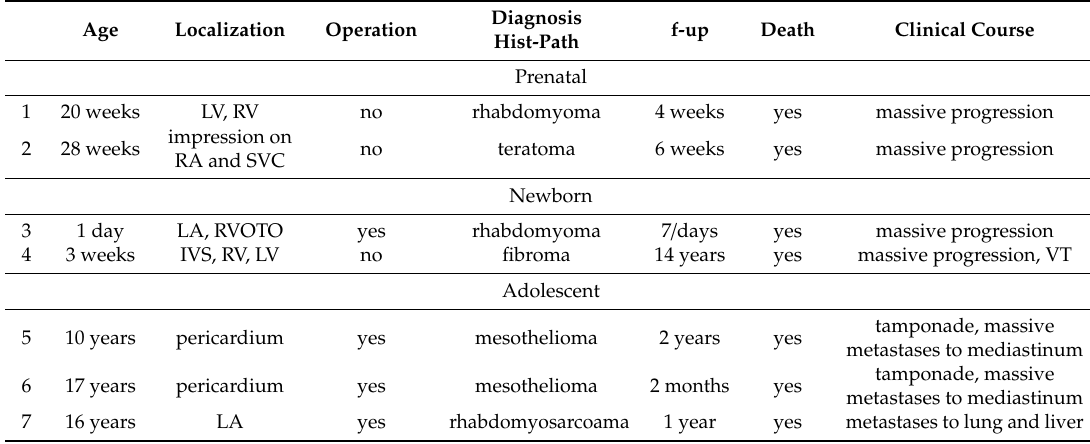
Table 6. Heart tumors that led to the deaths of